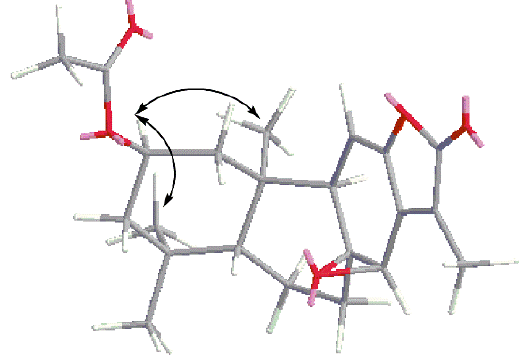
Figure 2. The key NOESY (H ↔ H) correlations of compound 1 .